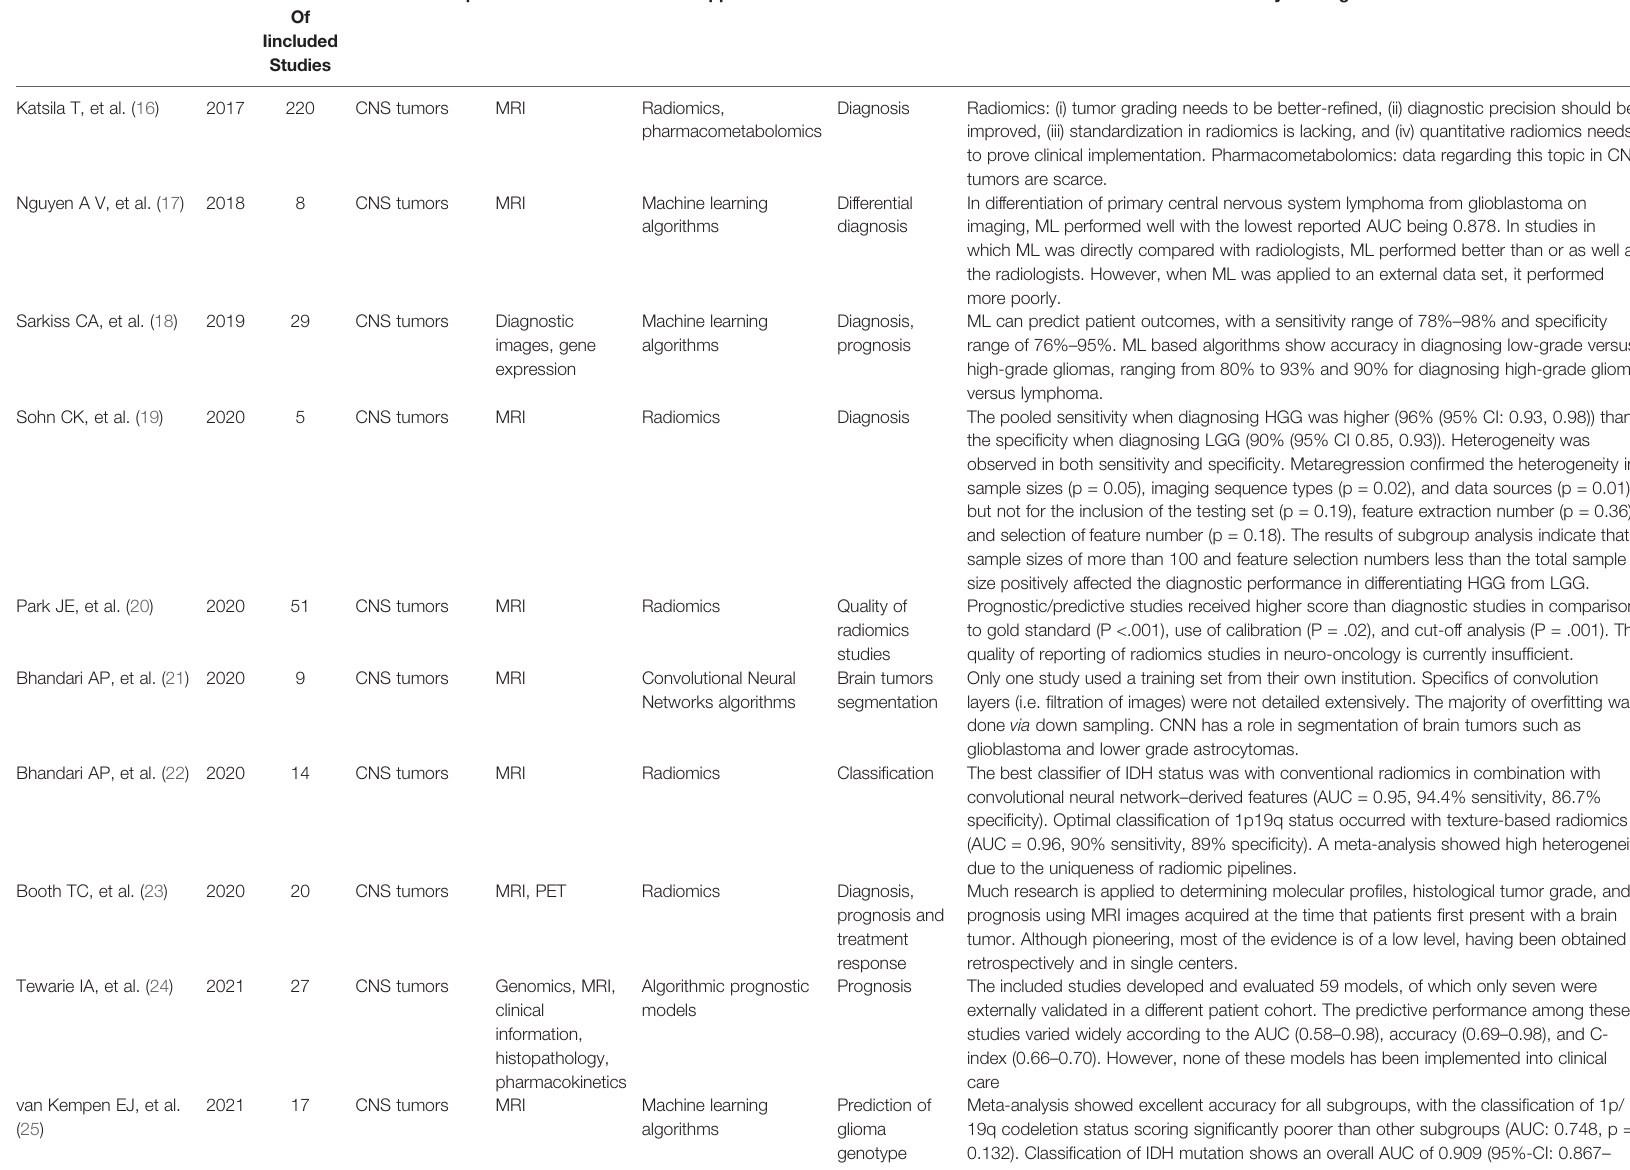
TABLE 1 | Summary of reviews included in the systematic